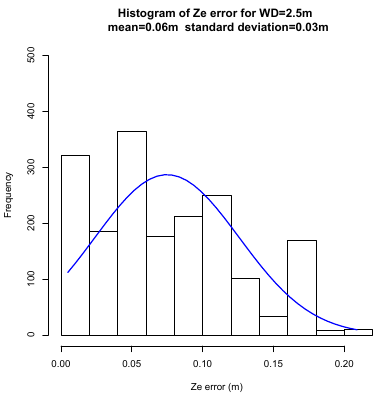
Figure 26. Histogram of Z e error for WD = 2.5 m. The curve in blue is the curve estimated by R as the Gaussian curve that is closest to the obtained